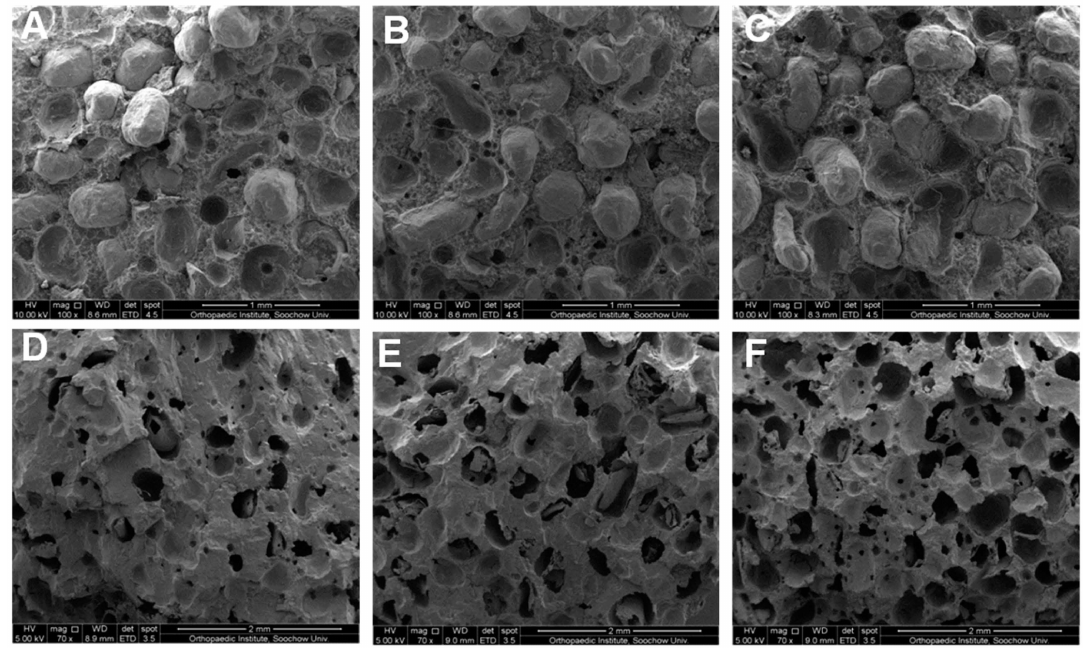
Figure 2. SEM images of composite bone cements. ( A , D ) PMMA–25Mg; ( B , E ) PMMA–41Mg and ( C , F ) PMMA–58Mg bone cements before ( A – C ) and after ( D – F ) degradation. Scale bars, 1 mm ( A – C ) and 2 mm ( D – F